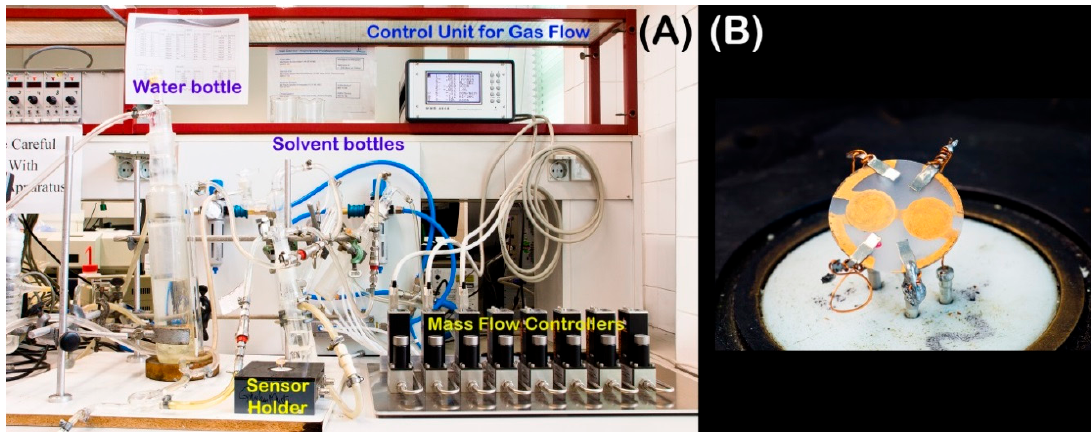
Figure 2. ( A ) Setup used for generating air streams with defined humidity and gas concentration; ( B ) Quartz crystal microbalance (QCM) mounted in measuring cell. ( B ) Quartz crystal microbalance (QCM) mounted in measuring